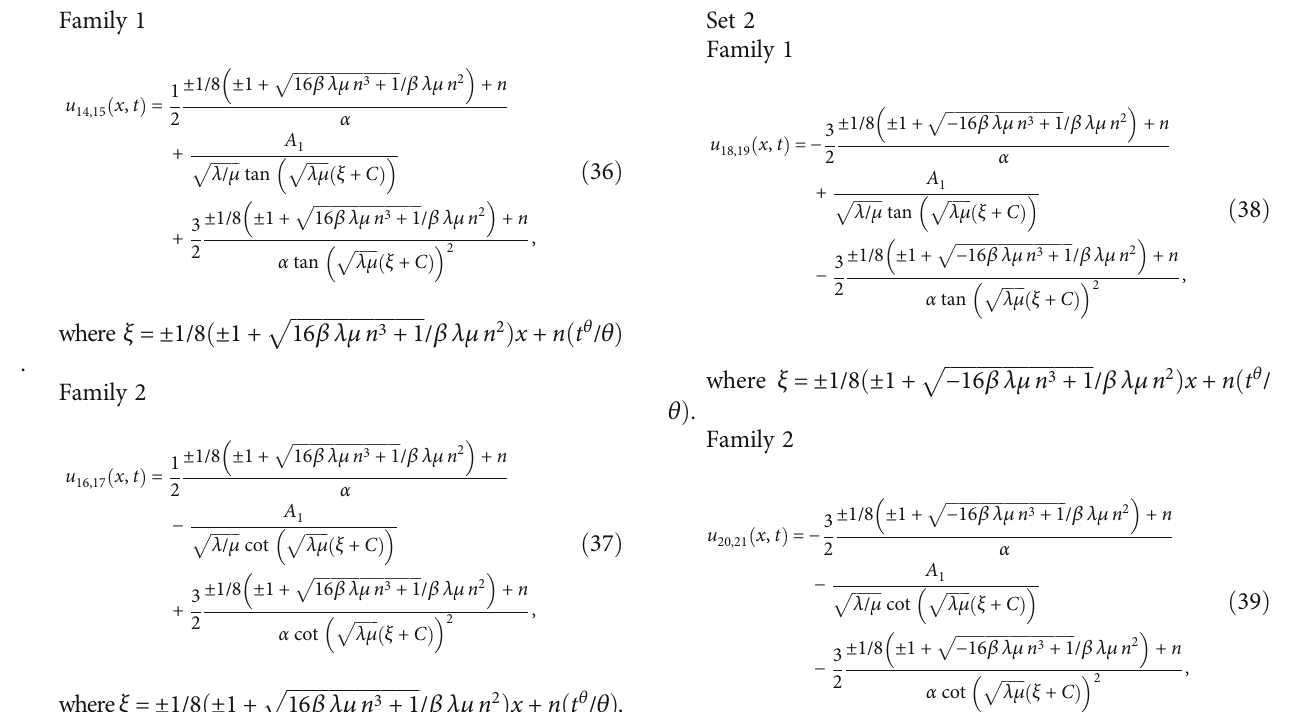
, y , t Þ . (a, b) 3D plot view representation and (c) 2D combined plot for x = 1 , 18,19 ð x